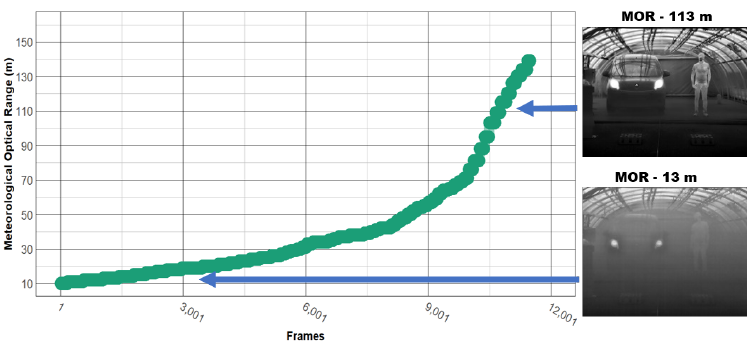
Figure 12. Dynamic scenario, protocol (i): targets at a fixed distance, MOR was varied from 10 to 160